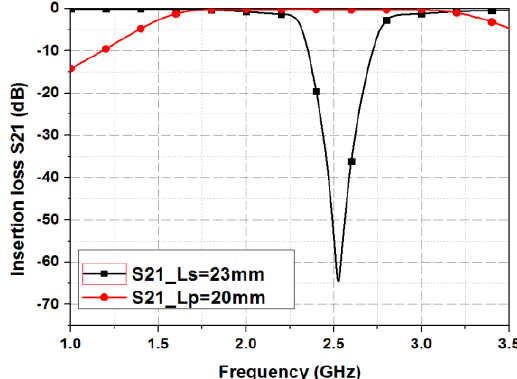
Figure 3. Simulated S-parameters of the proposed filter.